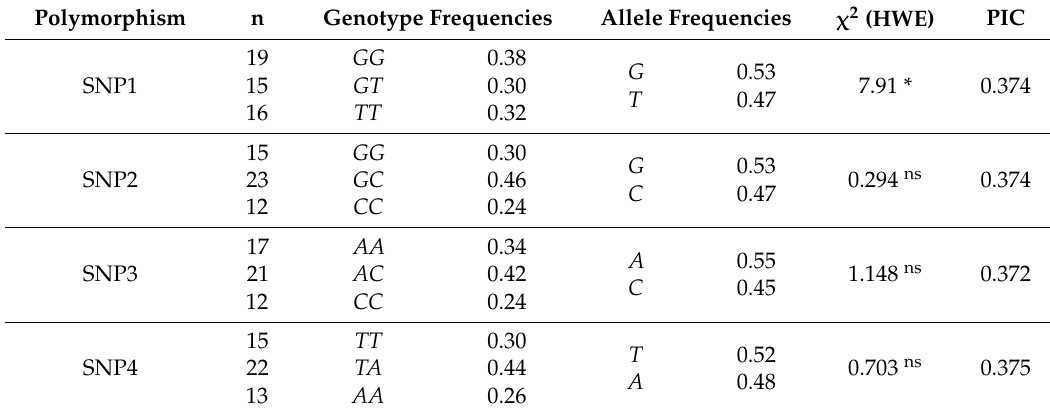
Table 2. Frequencies of genotypes and alleles of analysed polymorphisms in the SLC27A3 gene. Polymorphism n Genotype Frequencies Allele Frequencies χ 2 (HWE) PIC SNP1